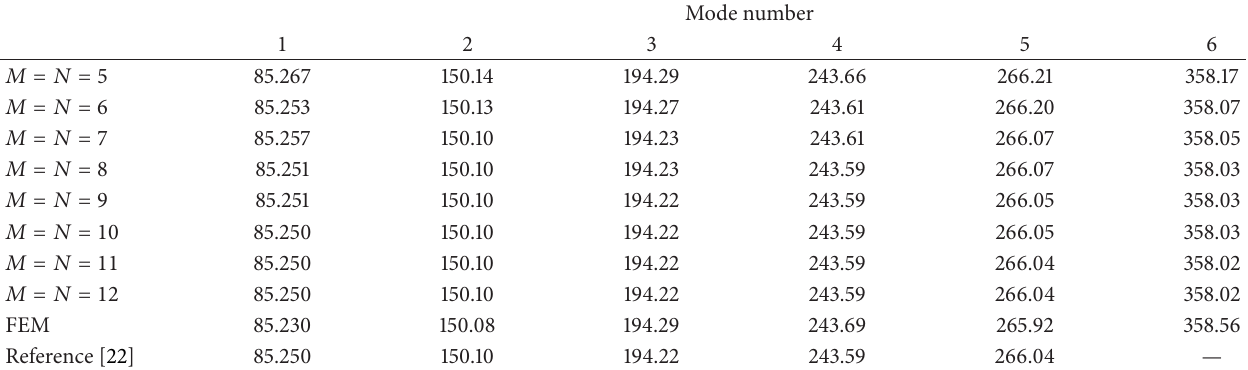
Table 1: Frequency parameters, Ω = 𝜔𝑏 2 (𝜌ℎ/𝐷) 1/2 , for a completely clamped annular sector plate ( 𝑎/𝑏 = 0.4, 𝜙 = 𝜋/3 , and 𝜇 = 0.33 ).